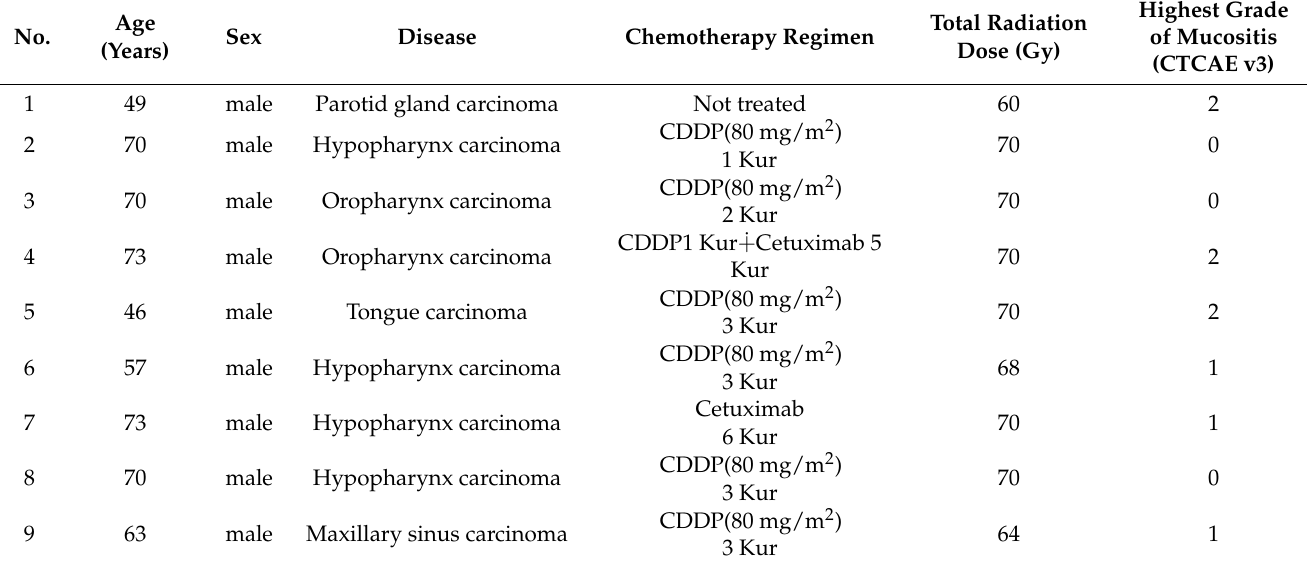
Table 1. Characteristics of the patients with head and neck cancers.